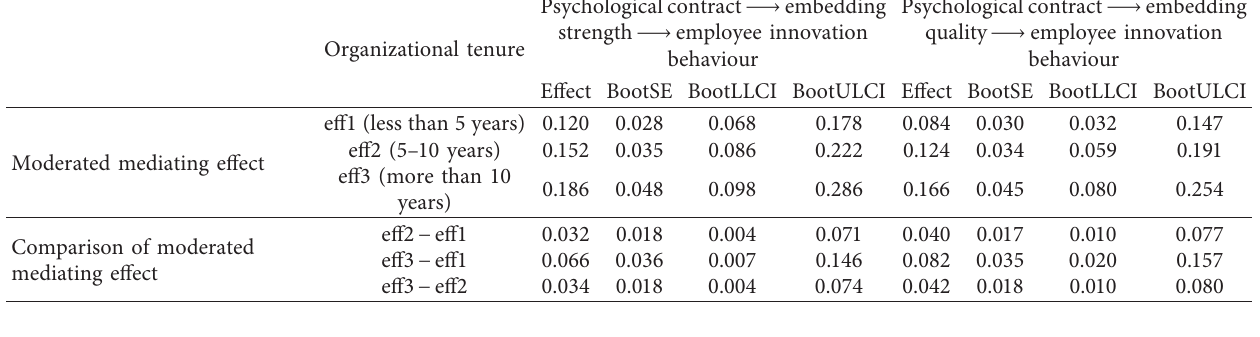
Table 6: Moderated mediated results for embedding strength and embedding quality across organizational tenure.